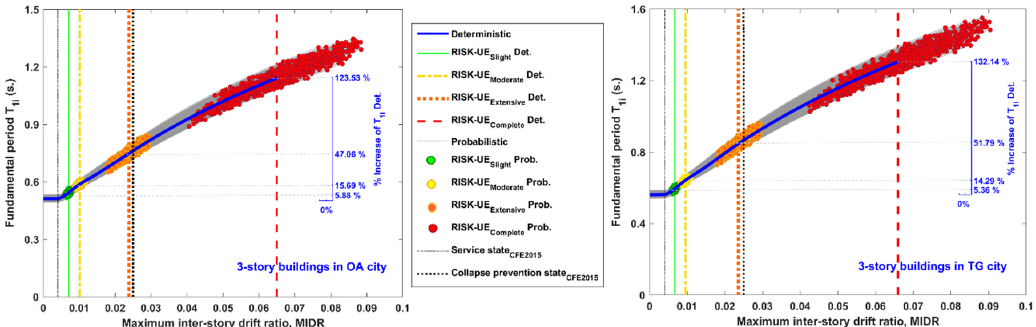
Figure 8. Deterministic and probabilistic T 1i –MIDR relationship curves of the 3-story buildings in OA and TG cities and their respective DS non-null .